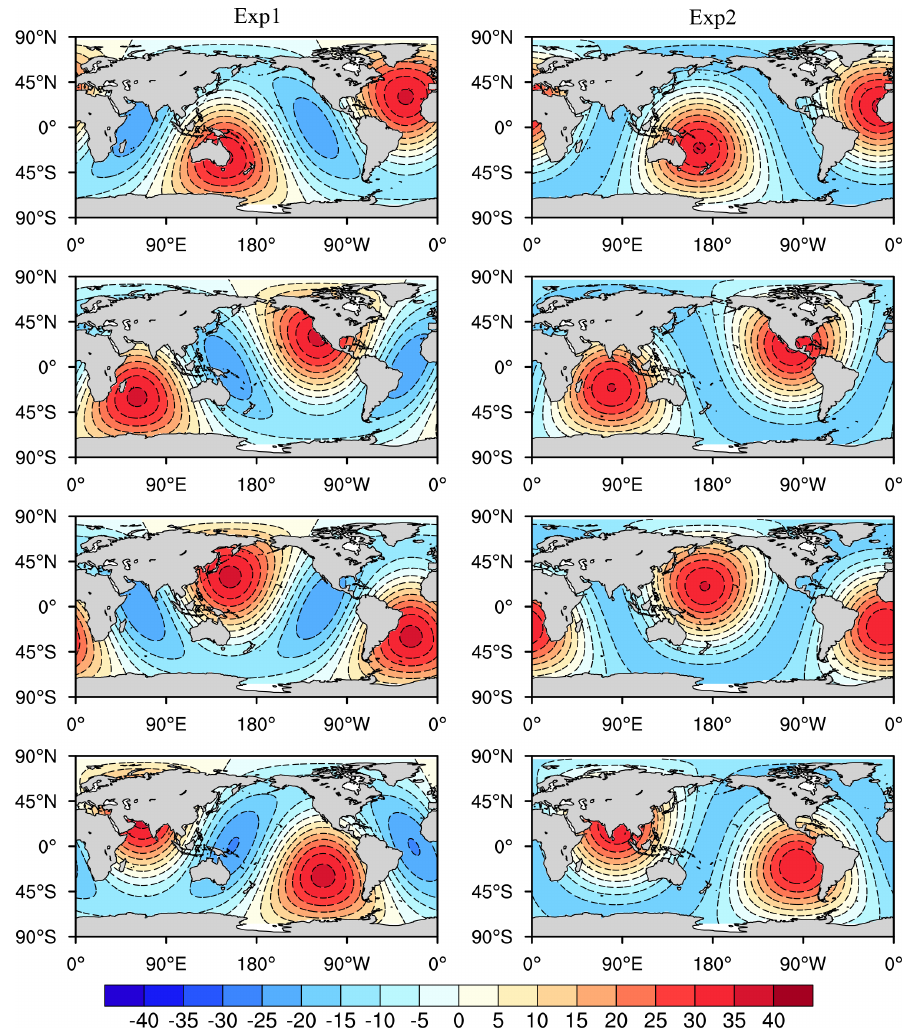
Figure 2. Spatial patterns of the spring tides for Exp1 (first column) and Exp2 (second column); the interval between the rows is 6h. The units are